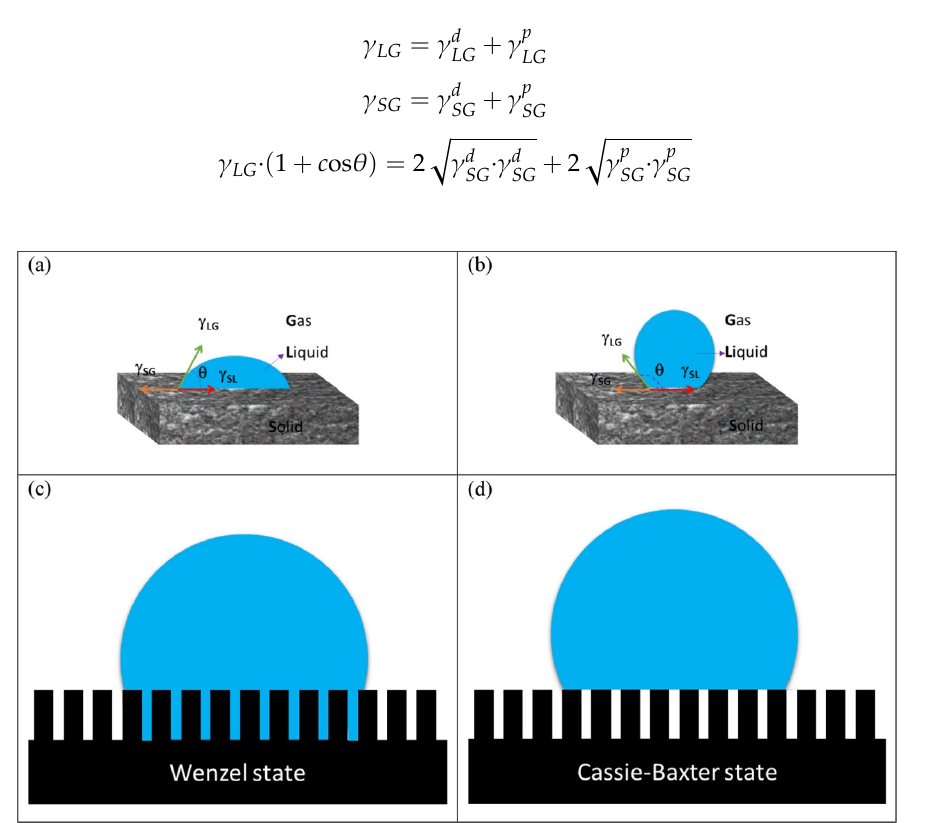
Figure 3. ( a ) Droplet on the flat surface with a contact angle lower than 90°; ( b ) higher than 90°; ( c ) Wenzel model; ( d ) Cassie-Baxter model (Reproduced from [113], with kind permission of Elsevier). Zhao et al. [40] used a nano-sol containing SiO 2 nanoparticles, 3-aminopropyltriethoxy silane (APTES) and hexadecyltrimethoxysilane (HDTMS) and sprayed the nano-sol on cotton, cotton/